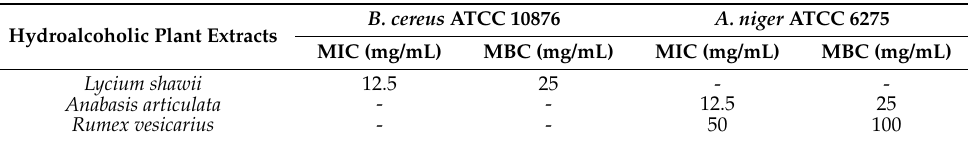
Table 6. Results of MIC and MBC of Lycium shawii (L), Anabasis articulata (A), and Zilla spinosa (Z) hydroalcoholic plant extracts and positive controls